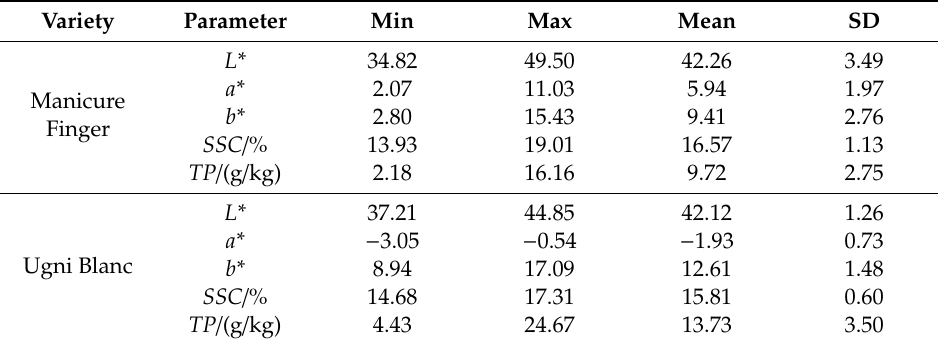
Table 2. Statistical results of each parameter for two